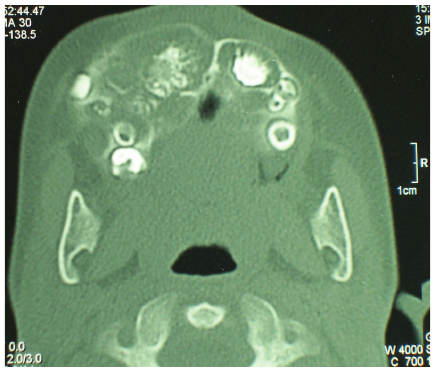
Figure 3: CT scan revealing hyperdense mass involving the labial cortex and pterygoid plates.